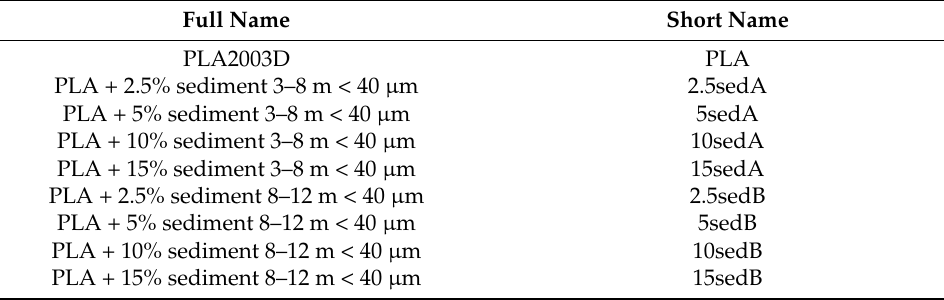
Table 2. Final concentrations of the filler in the tested